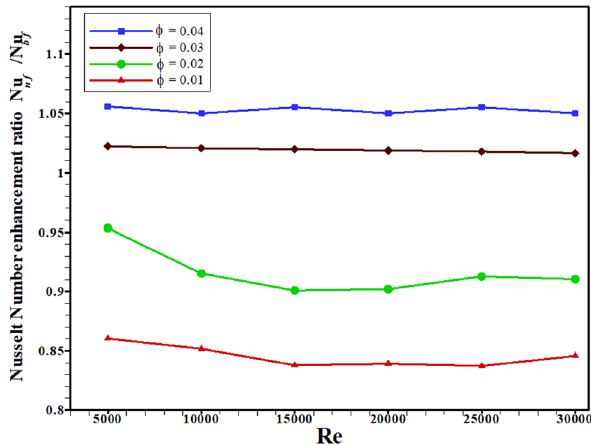
Figure 6: The enhancement ratio, Reynolds number variation for various volume fractions of metal oxide nanoparticles, and ϕ of water/SiO 2 nano fl uid with dp = 20 nm.